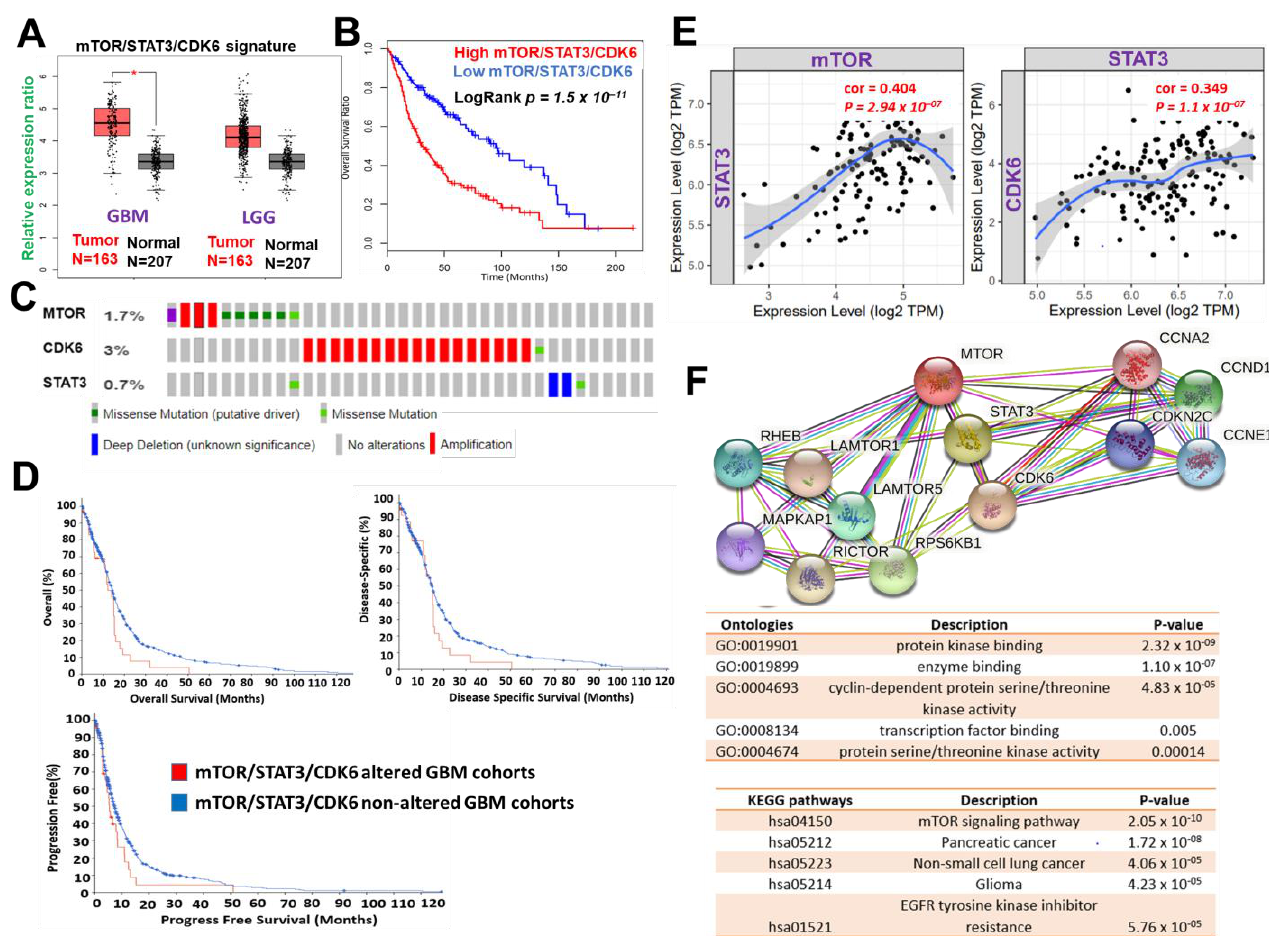
Figure 2. mTOR, STAT3 and CDK6 is an important oncogenic signature of disease progression, therapy failure, and poor prognosis in GBM patients. ( A ) Cumulative mTOR, STAT3, and CDK6 expression levels in the patients with GBM and low-grade glioma (LGG) from TCGA and GTEx datasets. ( B ) Kaplan–Meier plots of the cumulative survival of GBM patients. ( C ) Frequency of genetic alterations of mTOR, STAT3 and CDK6 signature in glioblastoma (TCGA, PanCancer Atlas) dataset. ( D ) Kaplan–Meier plots of the overall survival, disease-specific, and disease progressive free survival of GBM cohorts with genetically altered mTOR, STAT3 and CDK6 signature. ( E ) Correlation analysis of the expression between STAT3 and mTOR (left) and between CDK6 and STAT3 (right) from GBM TCGA databases. Both p -values and Spearman's rank correlation coefficient (cor) are indicated. ( F ) Protein–protein interaction networks of mTOR, STAT3 and CDK6 signature (upper panel) and the enriched KEGG pathways and gene ontologies in the mTOR, STAT3 and CDK6 clustering network.